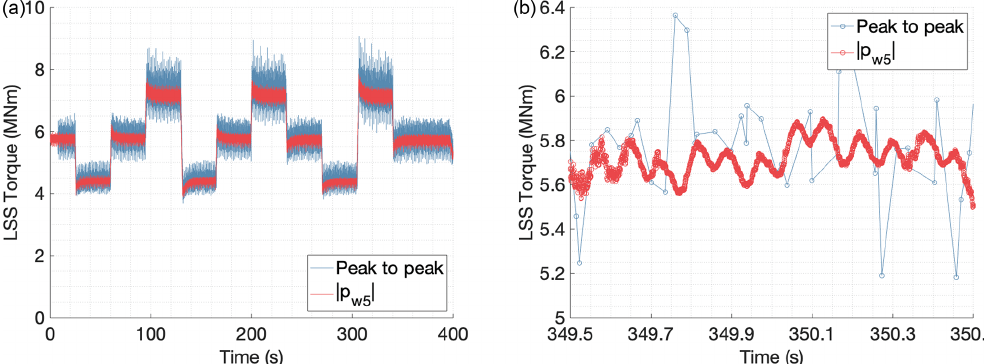
Figure 20. Torque estimates for a test with variable torque (steps); results for the entire test in panel (a) and 1s detail in panel (b) .